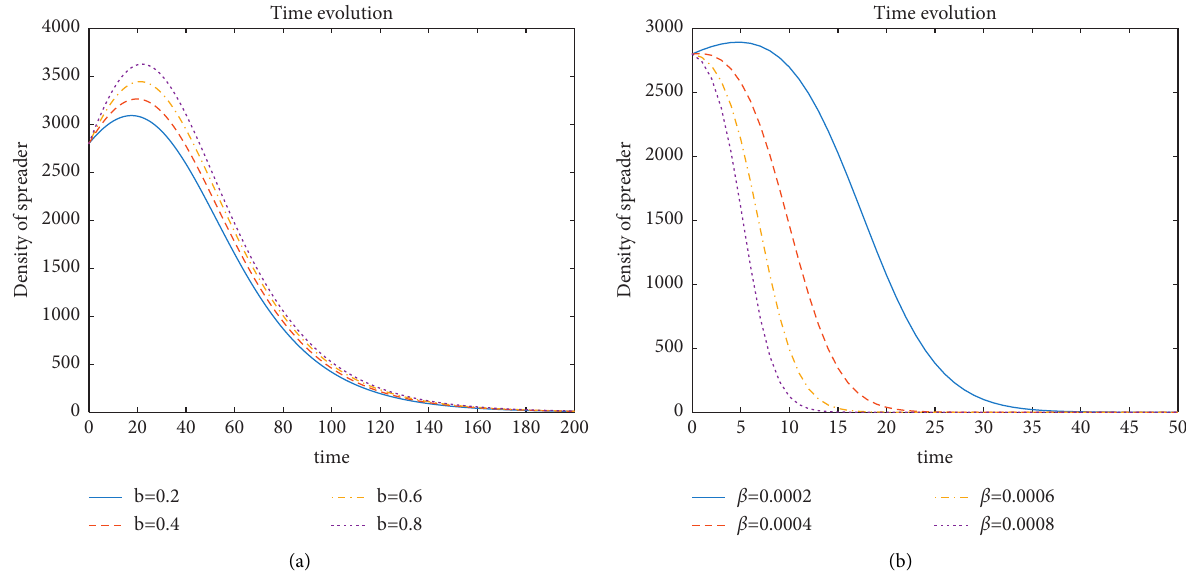
Figure 3: The impact of different parameters b , β on the density of rumor spreader without